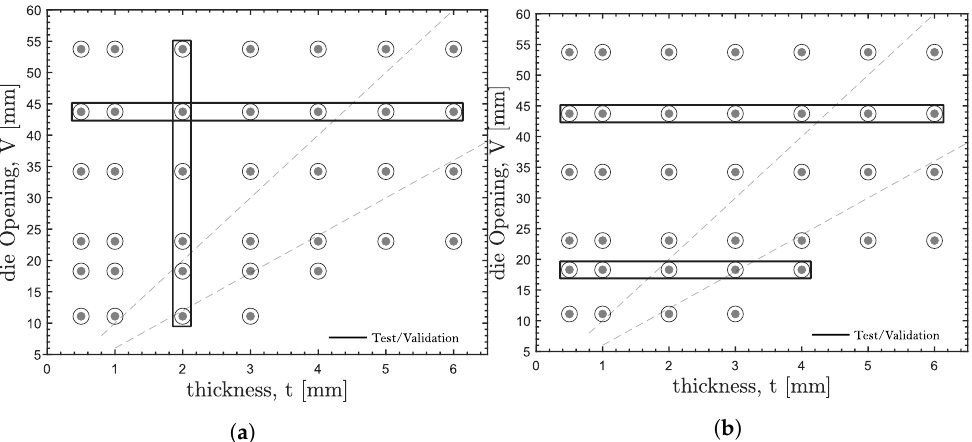
Figure 15. Selected bending processing conditions ( V / t ratios) for ( a ) data set division I (DD1) and ( b ) data set division II